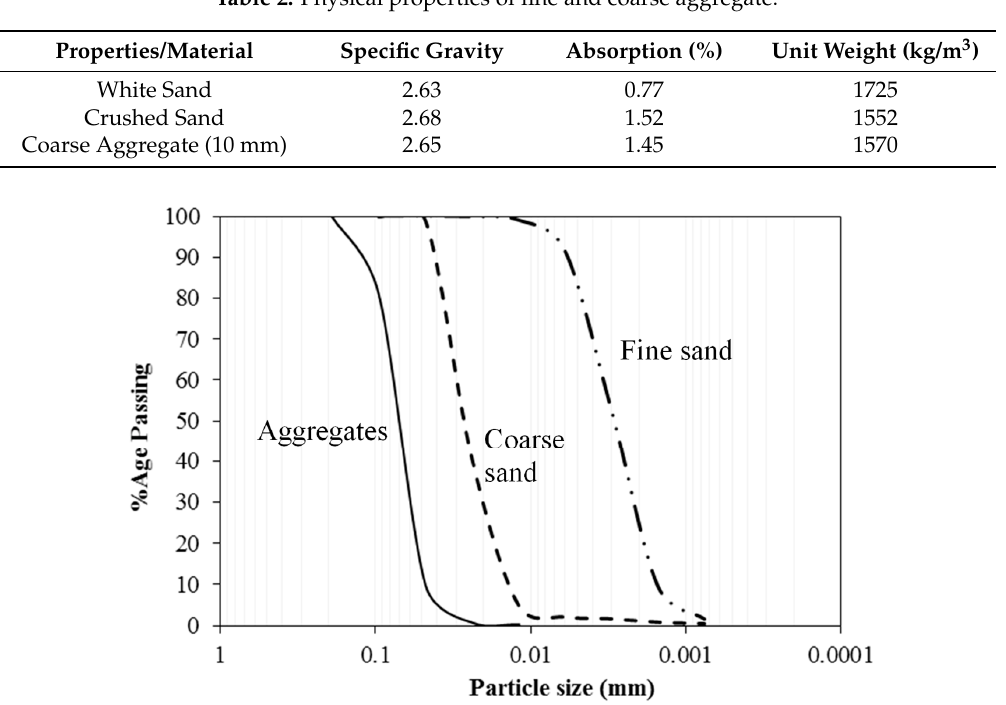
Figure 3. Particle size distribution of fine and coarse aggregate.